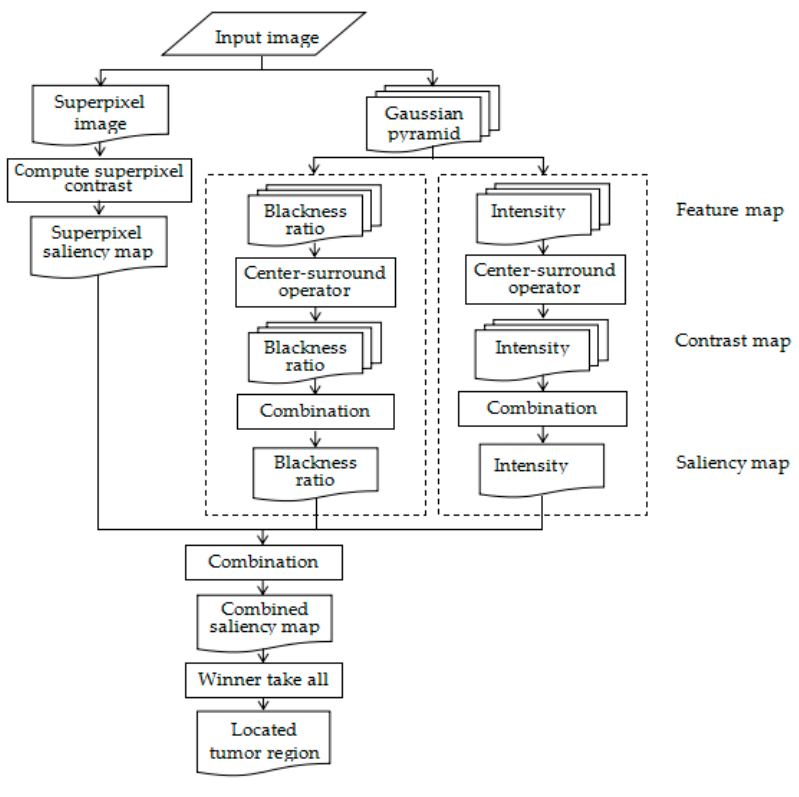
Figure 1. Proposed methodology.